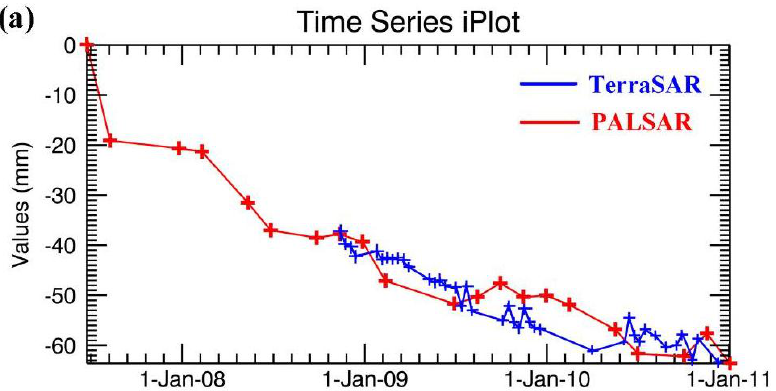
Figure 8. Quantitative validation by means of the cross comparison between ALOS PALSAR and TerraSAR; ( a ) time series at the point marked by the black cross in Figure 6; ( b ) the scatter plot of annual displacement rates from coincident CPs in Figure 6 (the point in (a) indicated by the red